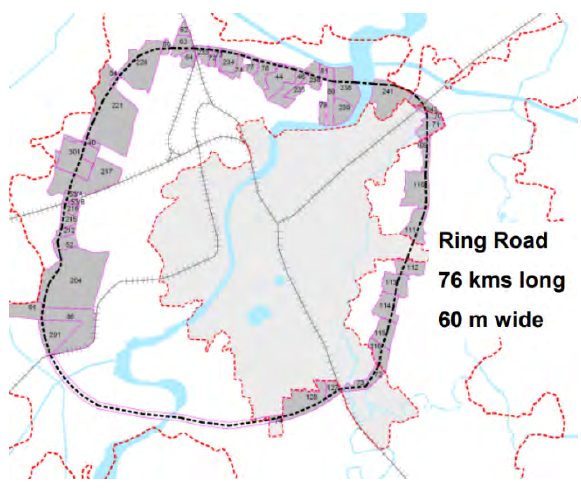
Figure 1. Town Planning Schemes along the SP Ring